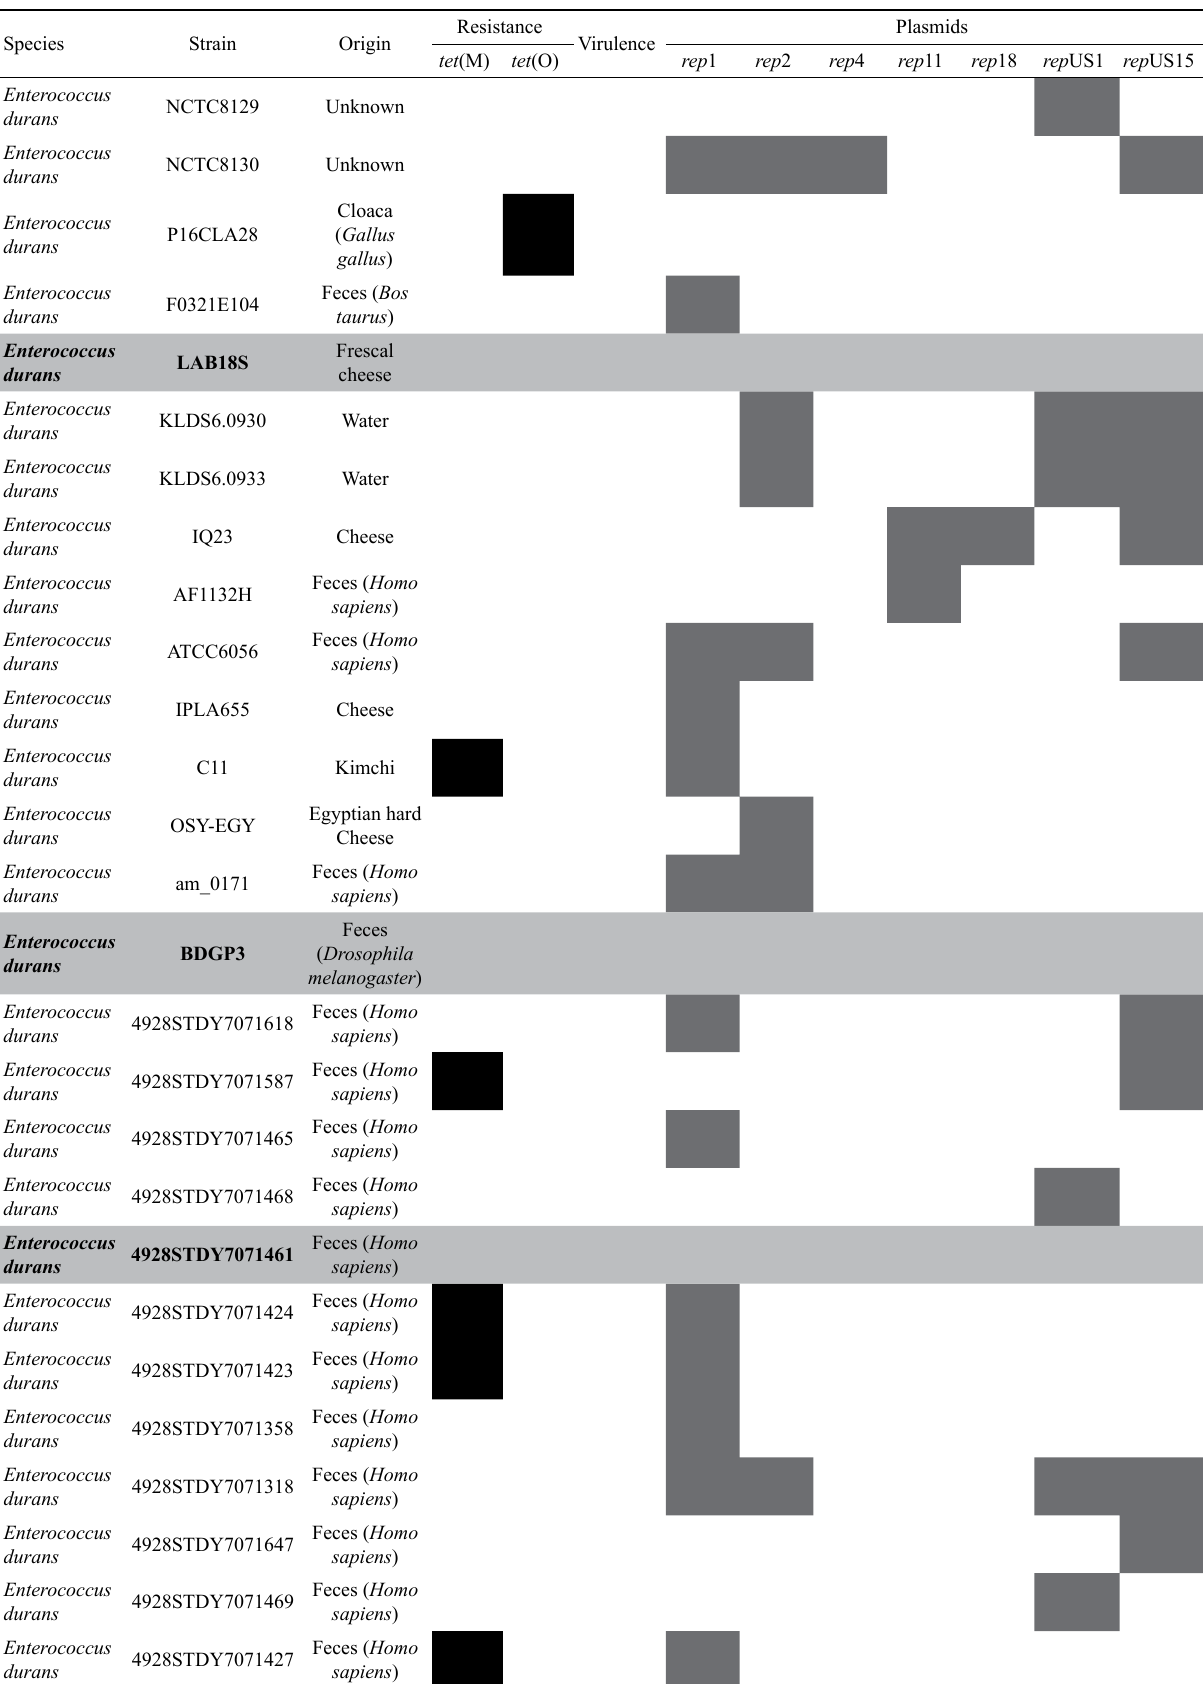
Table 4 – Comparative analysis of the presence of virulence genes, antimicrobial resistance genes and plasmids of 31 E. durans